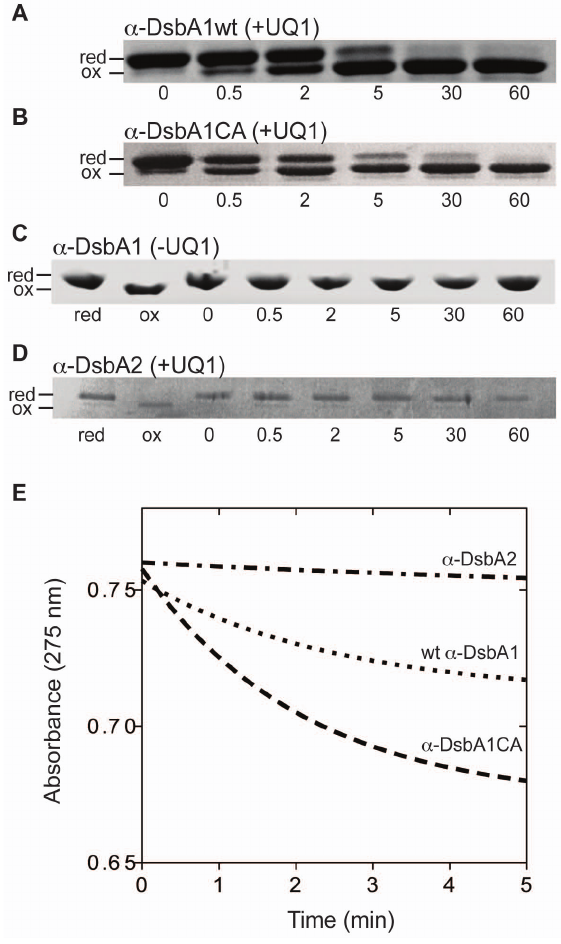
Figure 3. Redox interplay of a -DsbB with a -DsbA1, but not with a -DsbA2. ( A ) a -DsbA1 was oxidized in the presence of a -DsbB and UQ1; ( B ) a -DsbA1CA was oxidized in the presence of a -DsbB and UQ1; ( C ) a -DsbA1 was not oxidized in the presence of a -DsbB and absence of UQ1; lanes marked ‘‘red’’ and ‘‘ox’’ indicate samples of reduced or oxidized a -DsbA1, confirmed by use of Ellman’s reagent ( D ) a -DsbA2 was not oxidized in the presence of a -DsbB and UQ1; lanes marked ‘‘red’’ and ‘‘ox’’ indicate samples of reduced or oxidized a -DsbA2, confirmed by use of Ellman’s reagent ( E ) Ubiquinone reduction. UQ1 was not reduced when a -DsbB/UQ1 was mixed with a -DsbA2 but was reduced when a -DsbB/UQ1 was mixed with a -DsbA1 or with a - DsbA1CA. Samples of a -DsbA1, a -DsbA1CA and a -DsbA2 were in the fully reduced state (confirmed by use of Ellman’s reagent) prior to mixing with a -DsbB/UQ1. The data shown are representative of three replicates.